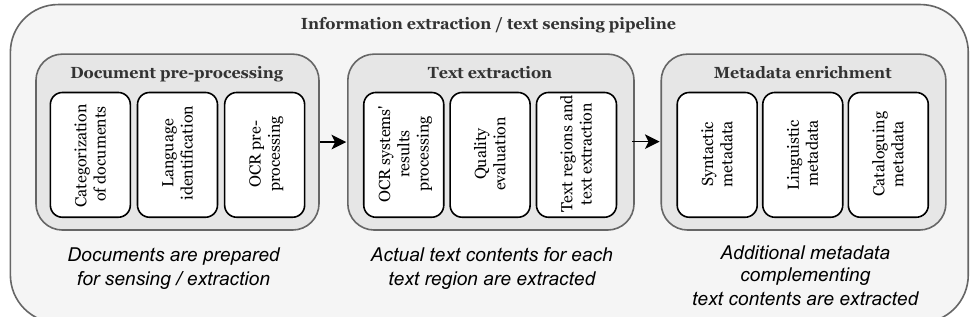
Figure 2. The information-extraction/text-sensing pipeline of the proposed approach: first, docu- ments are pre-processed in order to identify their language and submit them to the available OCR engines (left box); then, text extraction is performed, where OCR raw data is processed and evaluated and the text-region extraction, renumbering, merging and fusion approaches are performed (center box); finally, syntactic, linguistic and cataloguing metadata is sensed (right box). Detailed descriptions of the different phases are available in Section